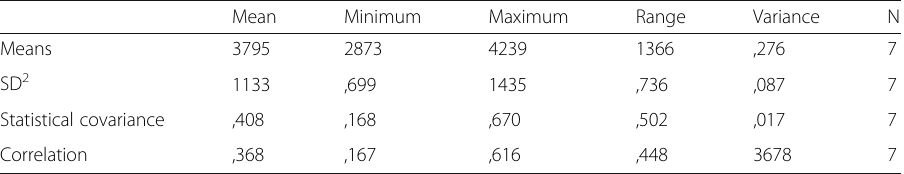
Table 8 Statistics among elements (VLE) Mean Minimum Maximum Range Variance N Means 3795 2873 ,276 SD 2 1133 ,699 Statistical covariance ,408 ,168 ,670 ,502 ,017 Correlation ,368 ,167 ,616 ,448 3678 7 Source: Own development by SPSS